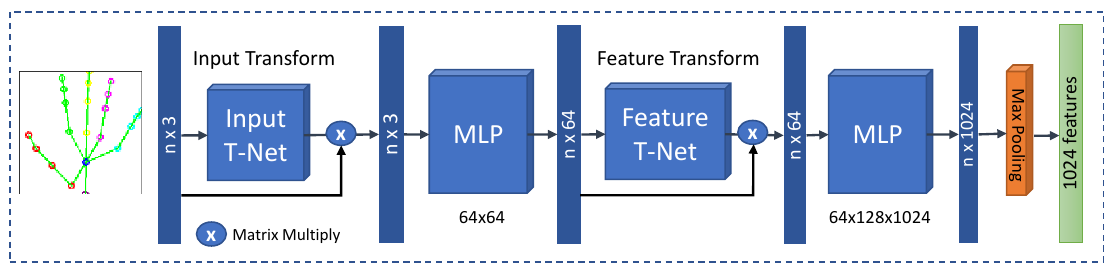
Figure 5. Point-Netarchitecture